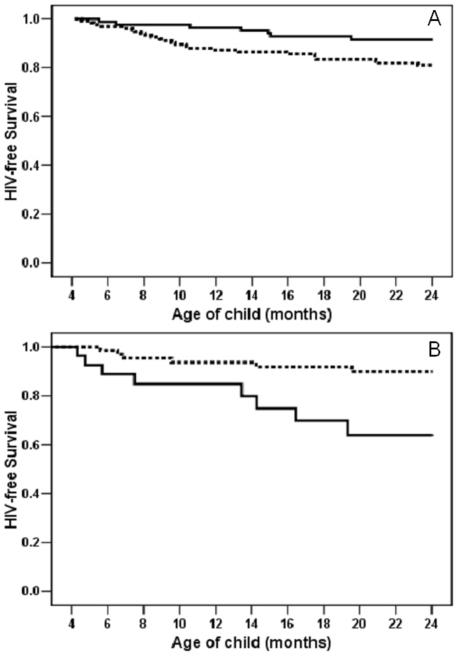
Panel A: HIV-free survival among 229 children in the intervention group whose mothers had less severe disease and would not have been eligible for antiretroviral therapy during pregnancy stratified by whether they adhered to the intervention (weaned by the completion of 4 months) (dashed line) or whether they continued breastfeeding after 4 months (solid line) (p = 0.035).Panel B: HIV-free survival among 97 children in the intervention group whose mothers had advanced disease and would have been eligible for antiretroviral therapy during pregnancy but did not receive it stratified by whether they adhered (weaned by the completion of 4 months) (dashed line) or whether they continued breastfeeding after 4 months (solid line) (p = 0.006).